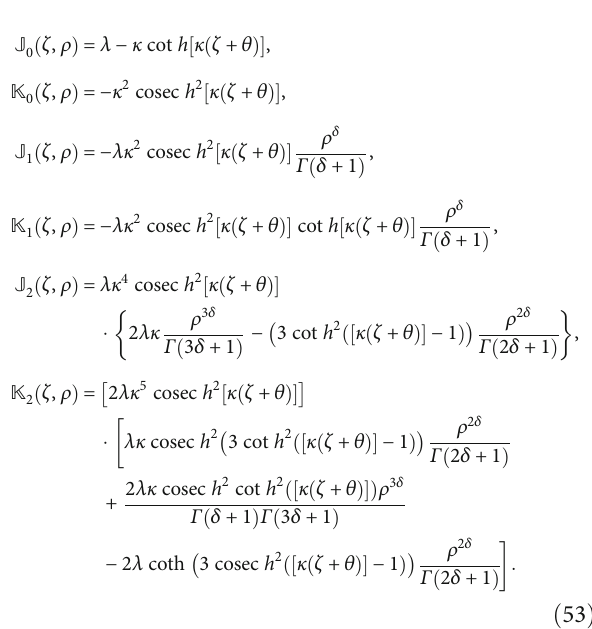
Figure 3: Graphical view of the analytical solution at various values of δ for J ð ζ , ρ Þ of system 1 .